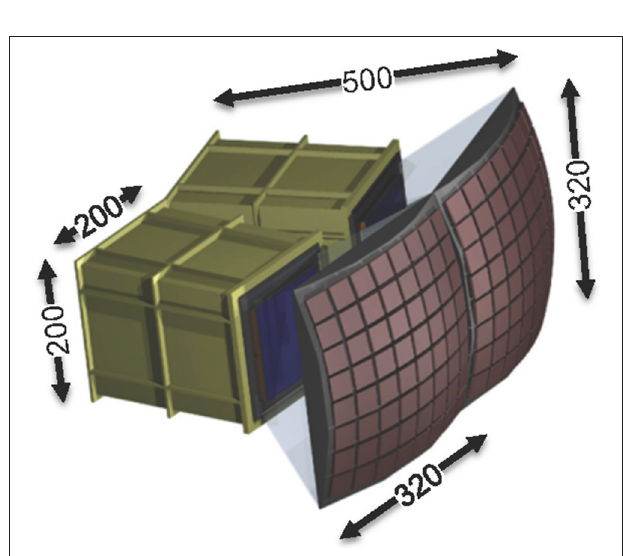
FIGURE 5 | Two of eight ATO-WFXT modules for localizing SBO events and high- z GRBs. The dimensions provided are in